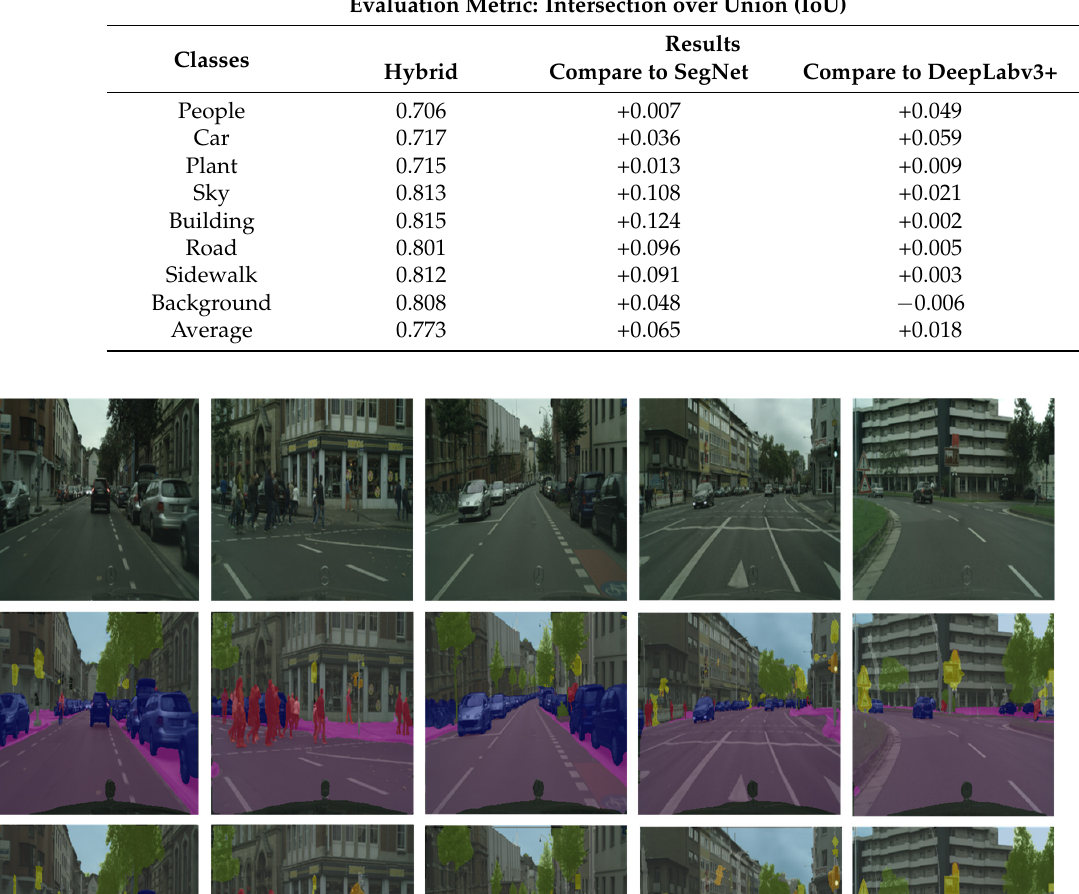
Table 2. Segmentation results for the cityscapes test dataset.